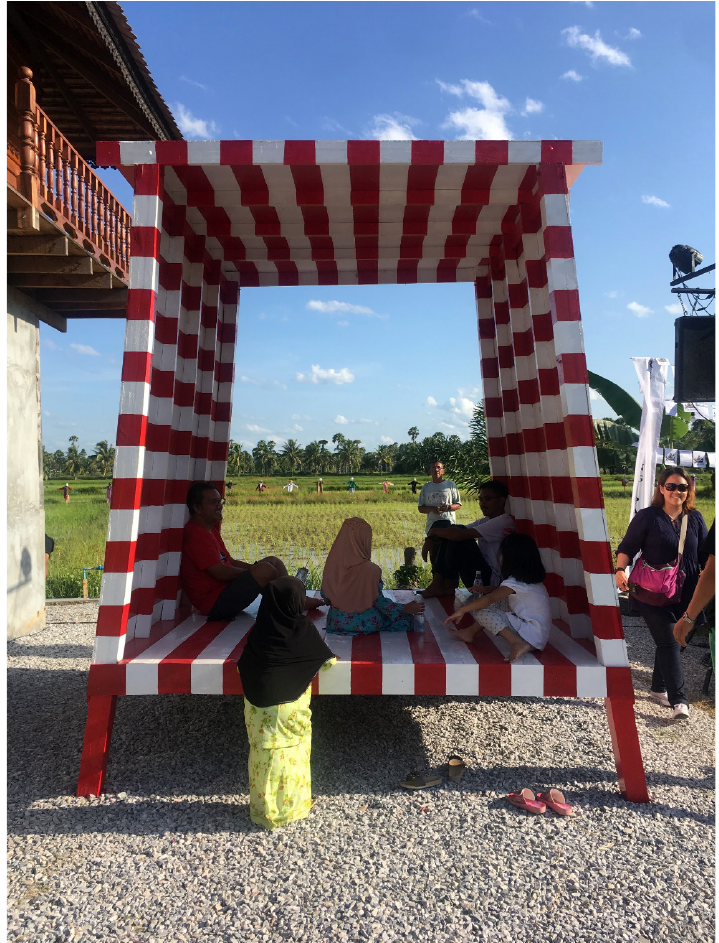
Figure 4. Patani Playhouse by Firhana Almuddin, made for RE/FORM/ING PATANI at Patani Artspace in Pattani (August 2018). Photo by the